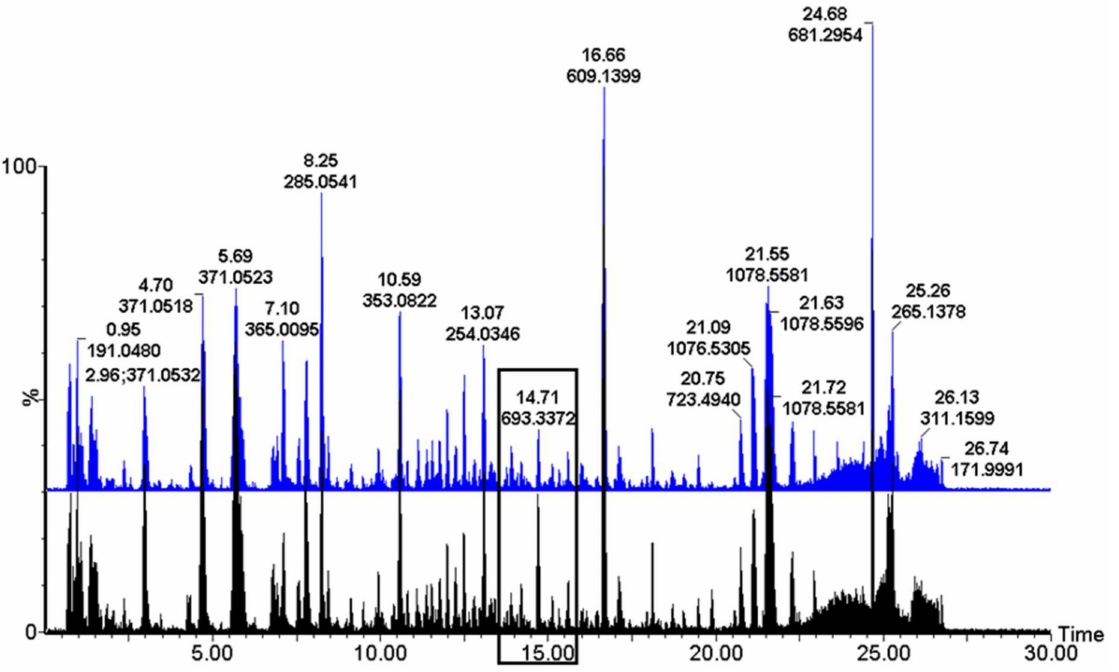
Figure 1. Overlay of representative original chromatograms obtained by ultra-high-performance liquid chromatography coupled to mass spectrometry (UHPLC-MS) of aqueous methanol extracts from tomato leaf tissue of viruliferous whitefly ( WF + Vir ) treated tomato plants of begomovirus-resistant tomato line (RT) (black) and its nearly isogenic susceptible counterpart ( S) (blue) on day 8. MS chromatograms ( m / z 100–1100) were acquired in ESI-negative mode. Retention times (in min) and accurate masses of the most intense signals are indicated in the chromatograms (plotted as base peak intensities (BPI), from 0 to 30 min). Some intensity di ff erences (e.g., the boxed area) indicate comparative quantitative di ff